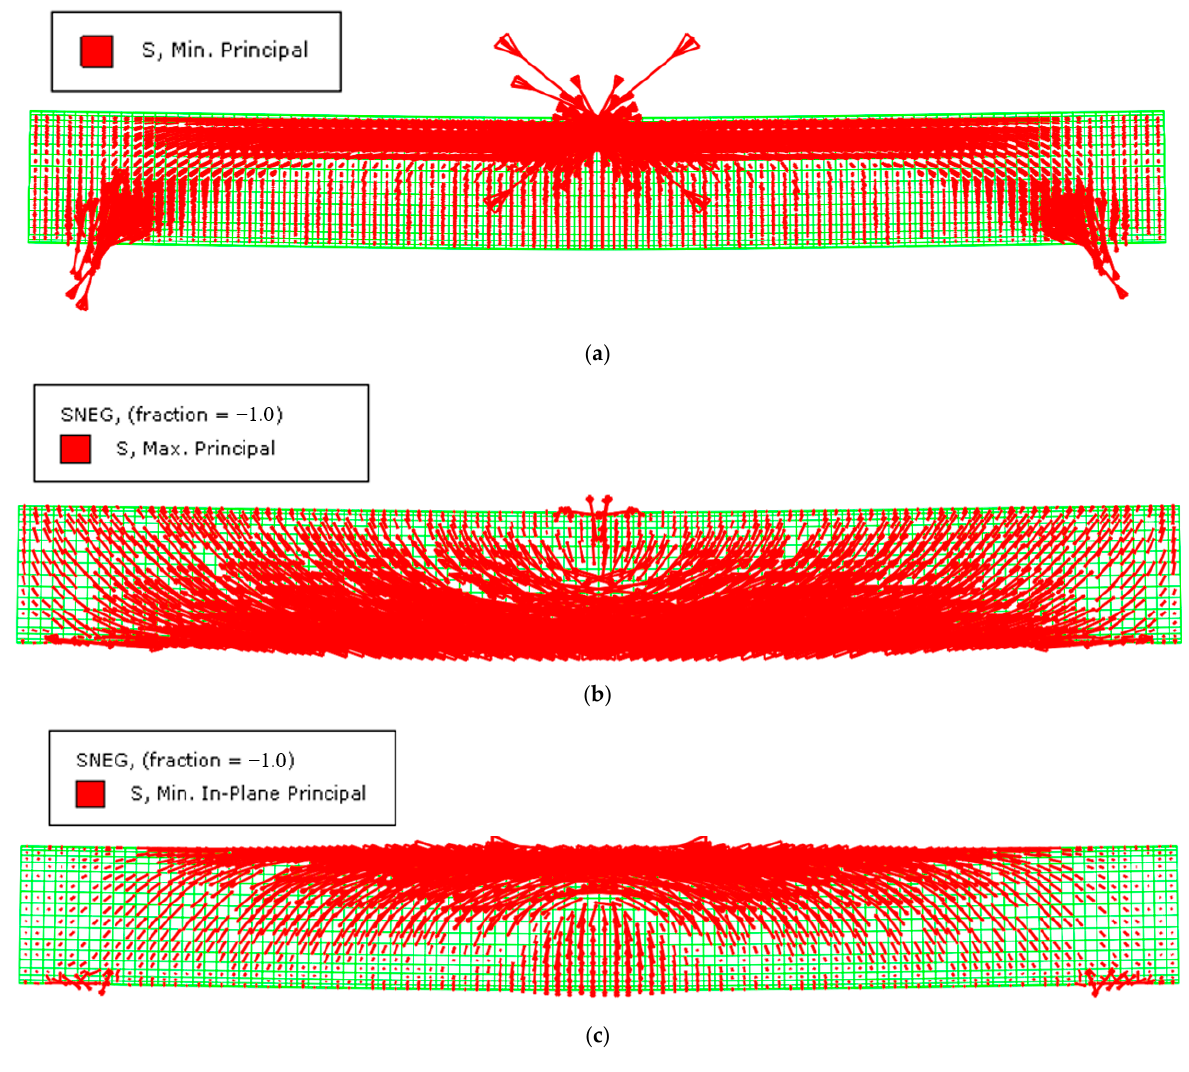
Figure 13. Maximum stress in CFHST beam. ( a ) Maximum compressive stress in concrete; ( b ) Maximum tensile stress in steel tube; ( c ) Maximum compressive stress in steel tube.